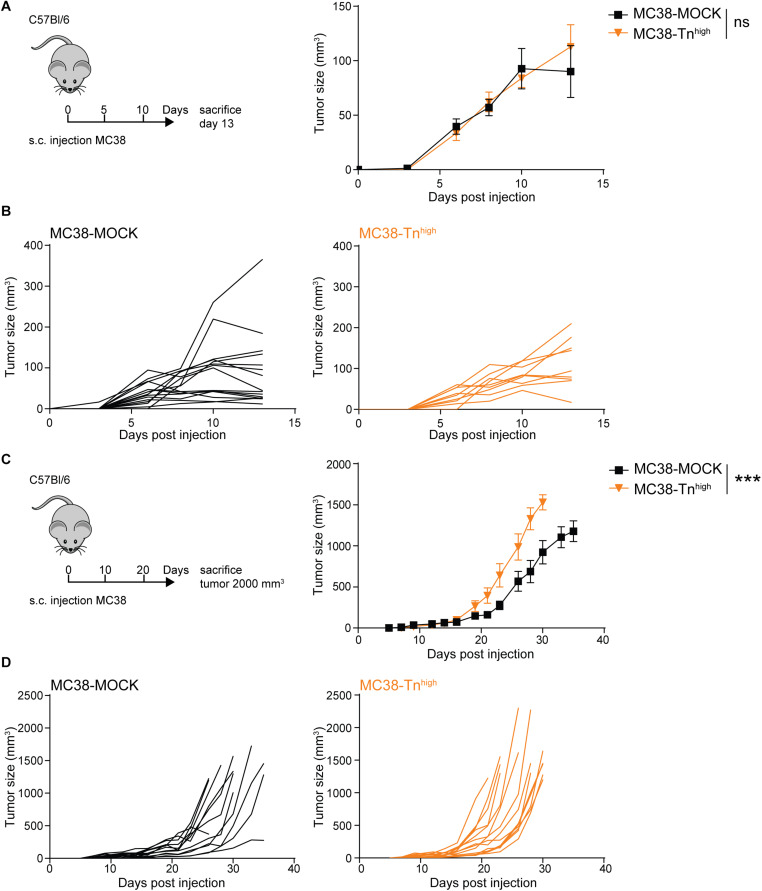
MC38-Tnhigh tumors display enhanced tumor growth at later phases of tumor development. (A–D) MC38-MOCK or MC38-Tnhigh cells were injected subcutaneously into C57Bl/6 mice and sacrificed at day 13 of tumor development (n > 10 mice/group) (A) or when tumor reached a size of 2000 mm3 (n = 14 mice/group) (C). Tumor growth is depicted as mean tumor size (A,C) or individual tumor growth curves (B,D). Mean ± SD; ***p < 0.001; ns, not significant.